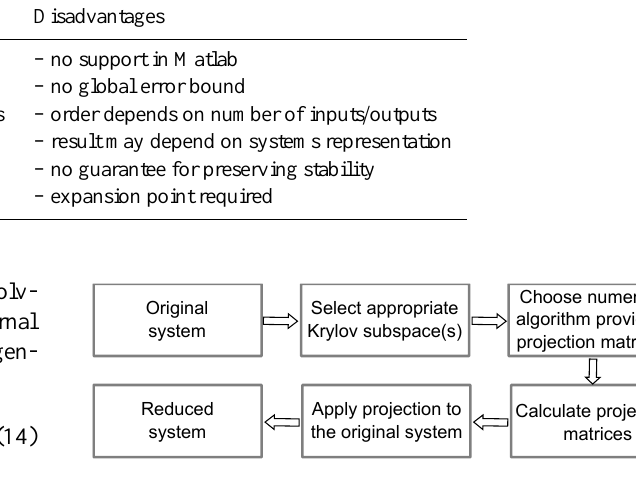
Figure 3. Key steps of dimensional reduction using Krylov sub-